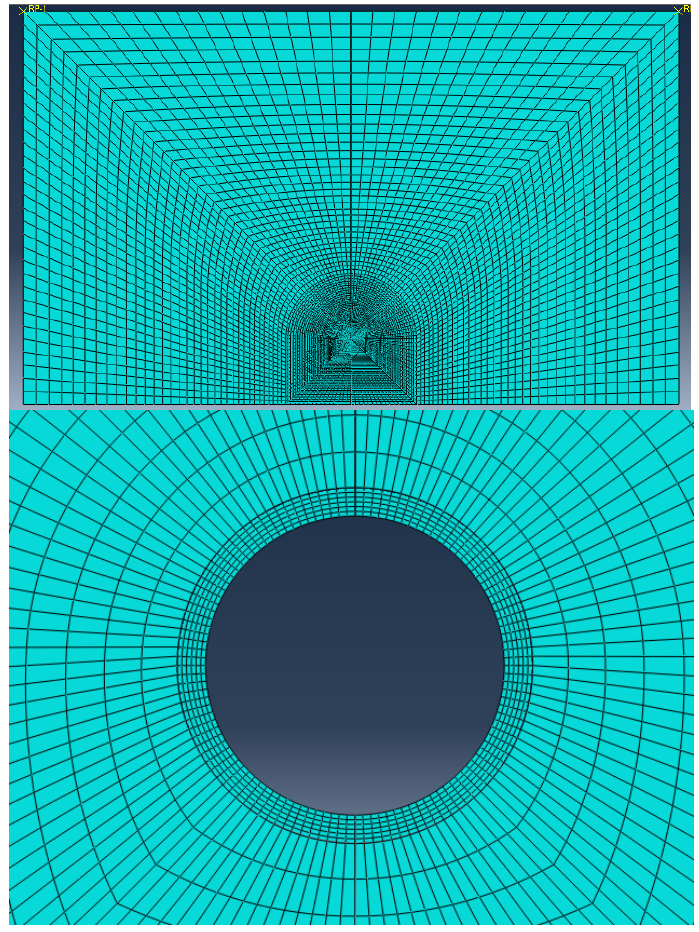
Figure 2. Finite element mesh of the mortar ( top ) and the area around the capsule ( bottom ).